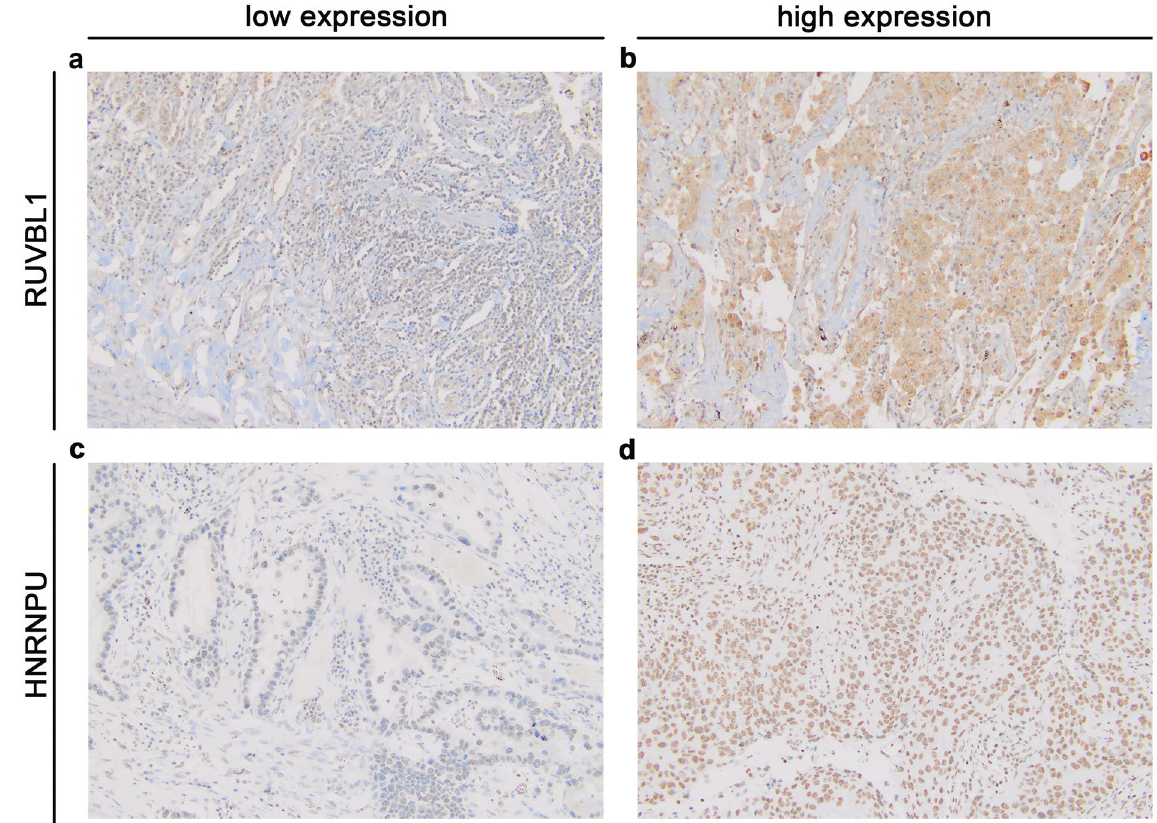
Fig. 1 Representative immunohistochemical staining for RUVBL1 ( a , b ) and HNRNPU ( c , d ) in NSCLC tissues. a Low cytoplasmic expression of RUVBL1, b High cytoplasmic staining for RUVBL1, c Low nuclear expression of HNRNPU, d High nuclear staining for HNRNPU.